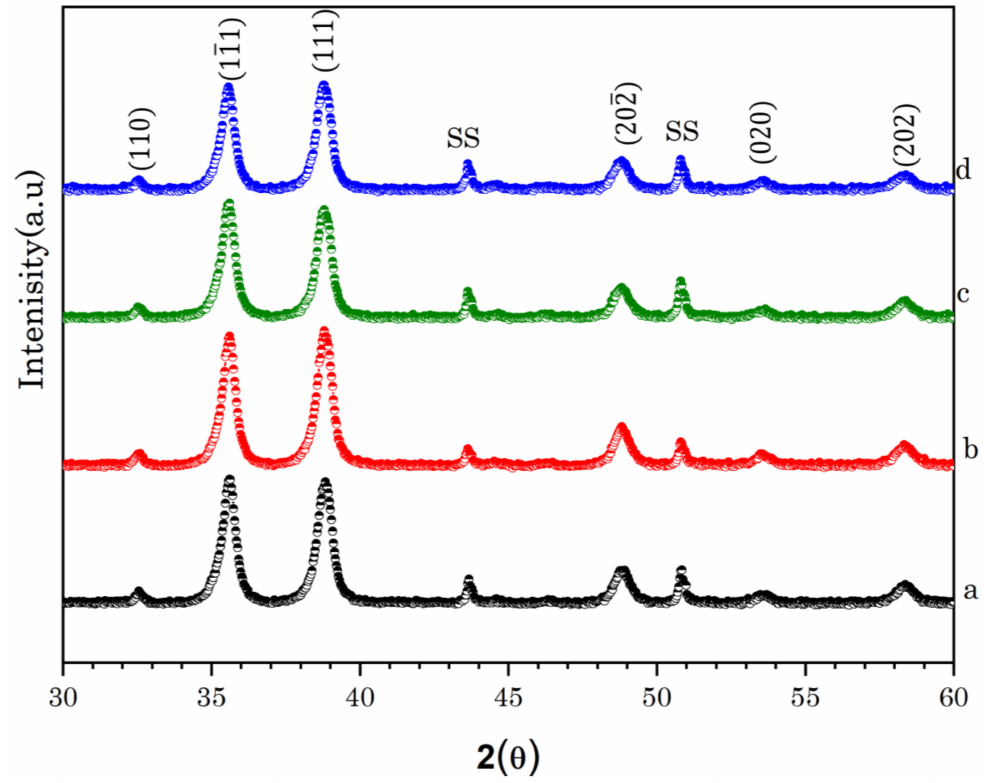
Figure 5. XRD patterns of CuO ( a ) 700 rpm, ( b ) 800 rpm, ( c ) 900 rpm, and ( d ) 1000